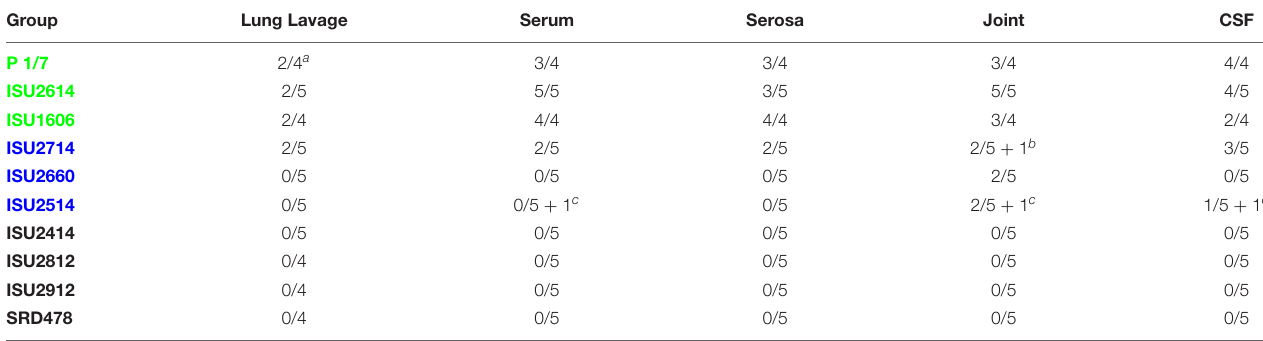
TABLE 3 | Frequency of S. suis culture from various sites from pigs that died or were euthanized after demonstrating clinical signs. Group Lung Lavage